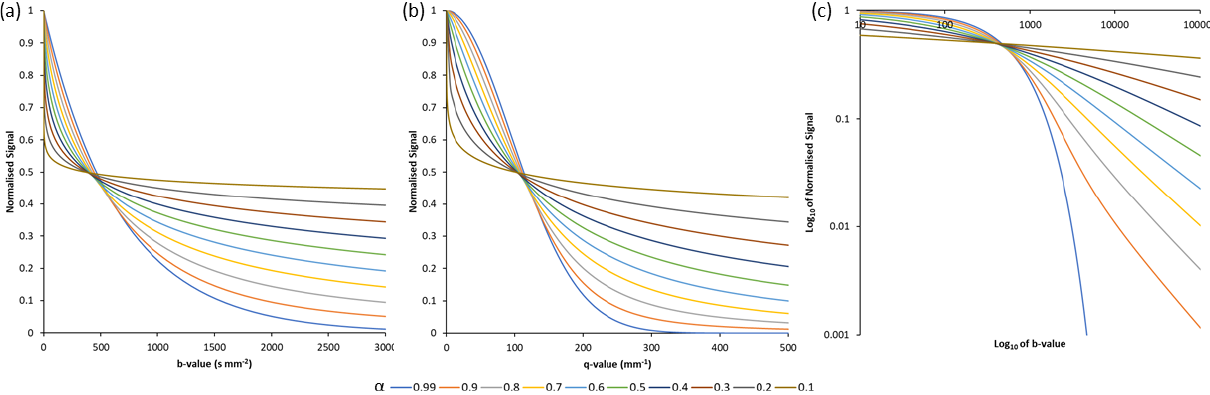
Figure 1. The family of quasi-diffusion imaging signal attenuation curves for an arbitrary diffusion coefficient of 𝐷 1,2 = 1.5 × 10 −3 mm 2 s − 1 and a range of fractional exponents, 0.1 ≤ 𝛼 ≤ 0.99 . Normalised signal is shown parameterised by ( a ) diffusion-sensitisation, 𝑏 , and ( b ) 𝑞 . Graph ( c ) shows the power law behaviour of the signal decay parameterised by 𝑏 on a logarithmic scale.